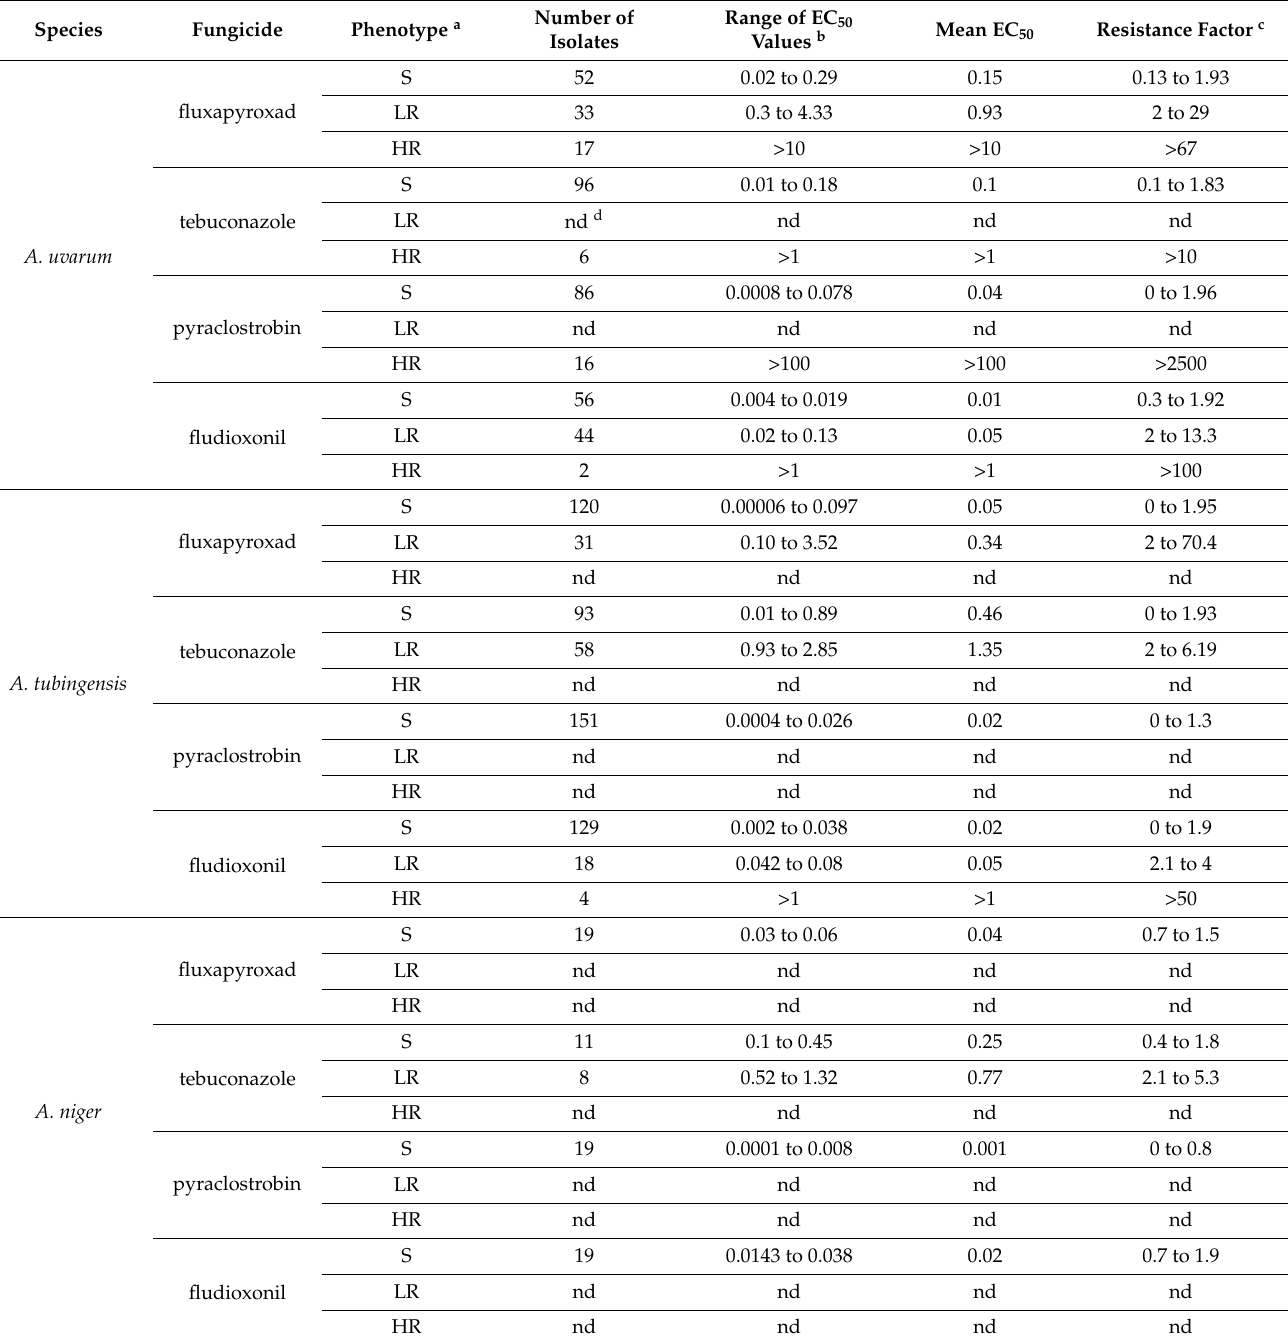
Table 2. Sensitivity measurements of Aspergillus section Nigri species from grapes to fluxapyroxad, tebuconazole, pyraclostrobin, and